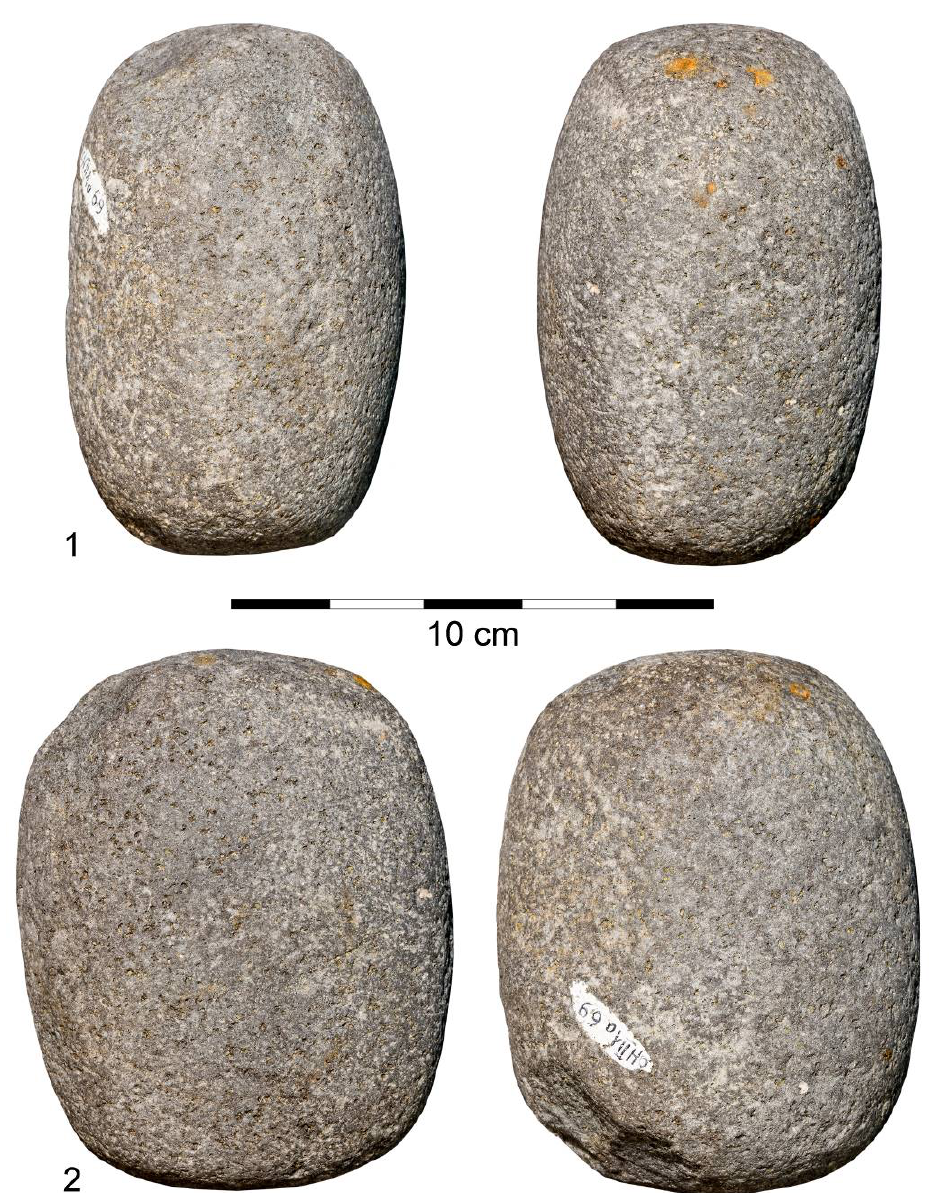
Figure 11. Basalt handstones used for two functions or more, hereby defined as multiple